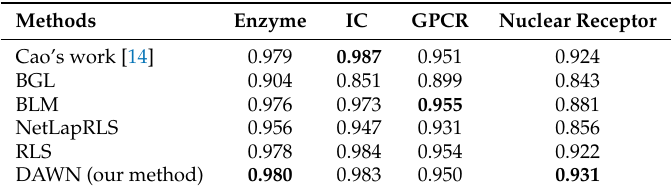
Table 3. The mean AUC values of five methods on balanced